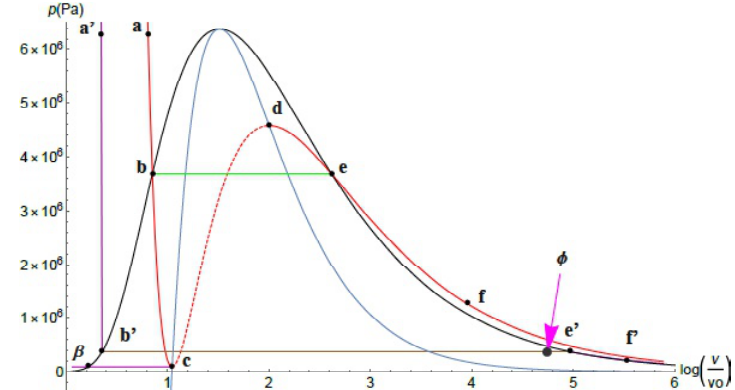
Fig. 5. The laser heats the system along the atmospheric isobar, going first through state  , then to state c located in the 479.9K isotherm. Sudden evaporation occurs there taking the system to state  . Subse- quent cooling due to heat exchange with the chamber walls liquefies the system bringing it back to state  where a new cycle begins.